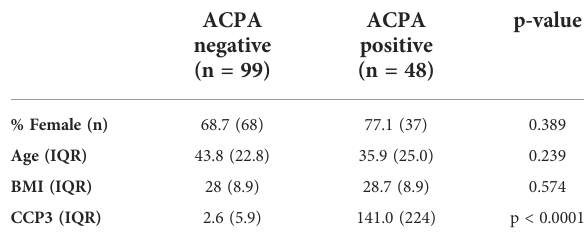
TABLE 1 Demographics of serum